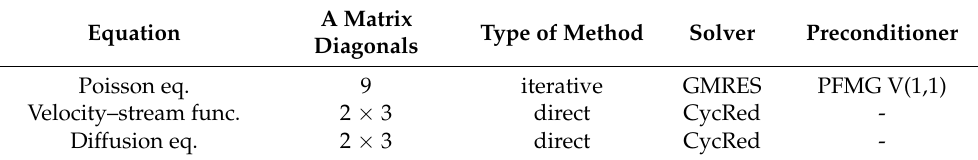
Table 1. Linear system of equations—solver selection. A Matrix Equation Type of Method Solver Preconditioner Diagonals Poisson eq. 9 iterative GMRES PFMG V(1,1) Velocity–stream